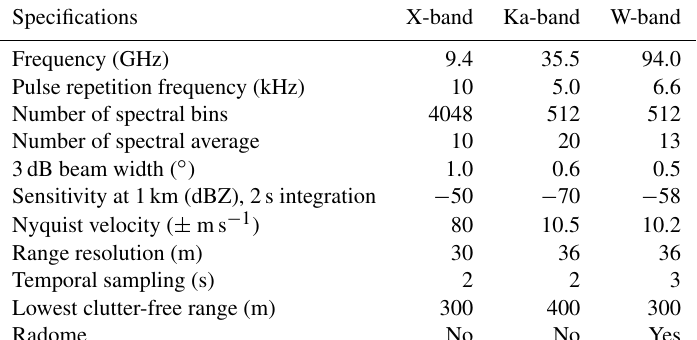
Table 1. Technical specifications and settings of the three vertically pointing radars operated during TRIPEx-pol at JOYCE-CF. Note that the W-band radar is a FMCW system for which chirp repetition frequency, number of spectral average, Nyquist velocity and range resolution change for different range intervals (see details in Dias Neto et al., 2019); values are provided here are for the lowest range gate region from 220 to 1480m. Additionally, the radome of the W-band is equipped with a strong blower system which presents rain from accumulating.